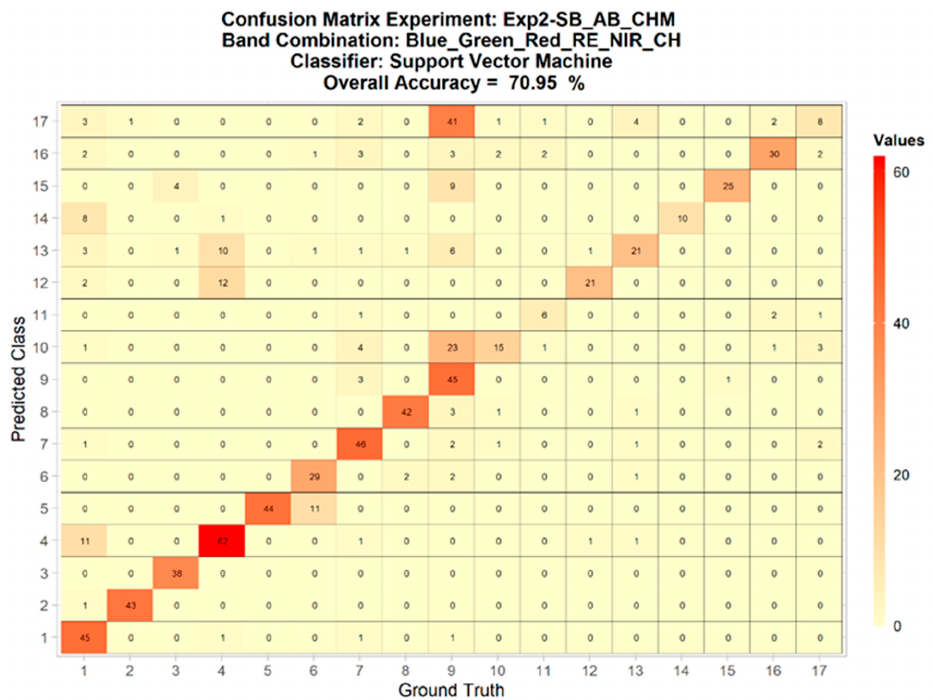
Figure A14. Confusion matrix for the best results obtained in Exp2-SB_AB_CHM, using the Random Forest classifier (the Blue_Green_Red_NIR_CH band combination).